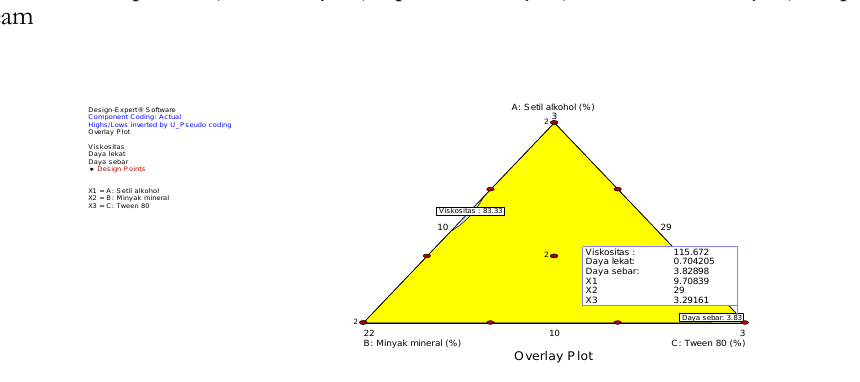
Figure 1. Countourplot a) Viscosity, b) Spread Ability, c) Adhesive Ability d). Superimposed